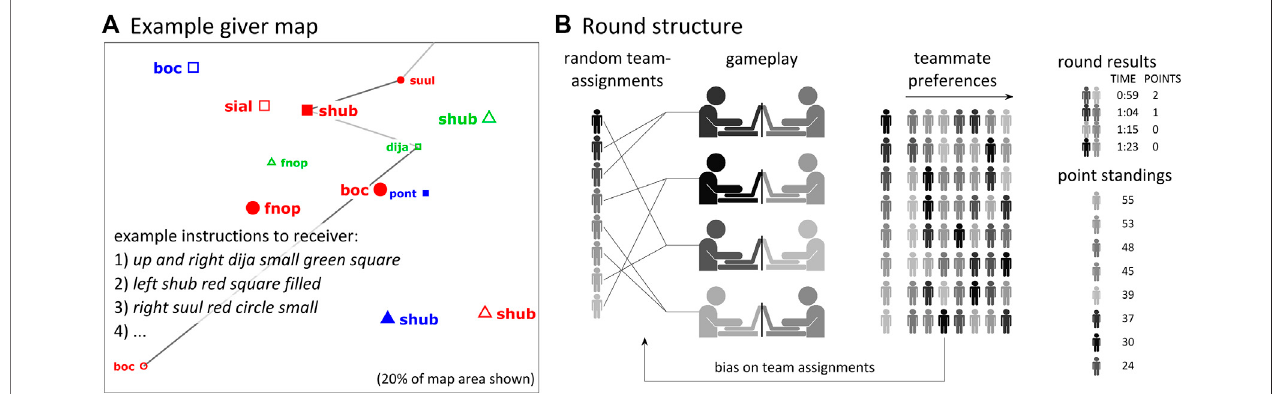
FIGURE 3 | Example map and round structure. (A) Giver map with route from starting location. 20% of map area is shown. The receiver has an identical map, withouttheroute. Example instructions toreceiverfor the fi rstthree path segments are shown. (B) Round structure: each round begins withrandom team assignments; after completing a game, participants produce con fi dential teammate preference rankings. Points are awarded to players on the two fastest teams in the round and cumulative point standings are displayed to all players. The teammate preference rankings are used to bias random team assignments in the next